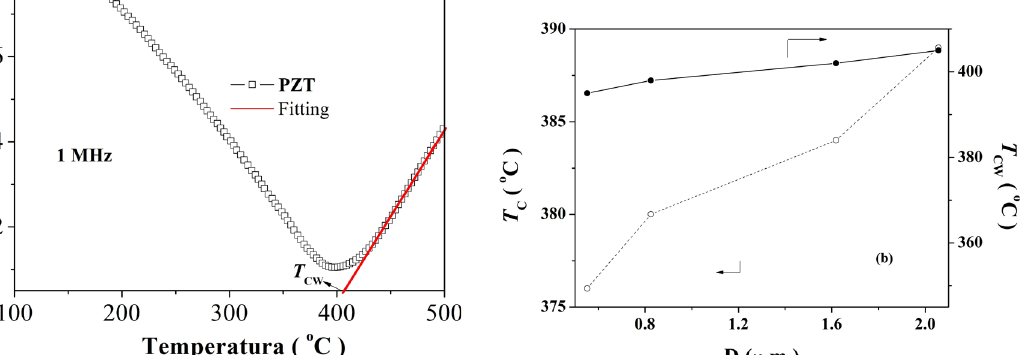
Figure 8. Dependence of the temperatures of Curie ( T c Weiss ( T ) with the grain size (D) of the materials cw